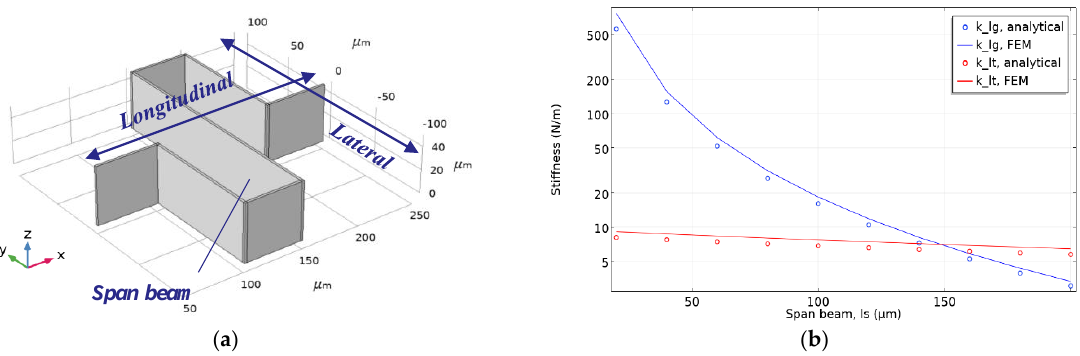
Figure A1. ( a ) A 3D model of the serpentine flexure design used in the AUC with dimensions corresponding to Table 1, plotted in COMSOL. ( b ) A comparison of the analytically derived and 3D-FEM-based longitudinal and lateral spring constants with a sweep of the span beam of the serpentine flexure shown in ( a ). The longitudinal spring constant shows greater sensitivity to the span length than the lateral spring constant does.